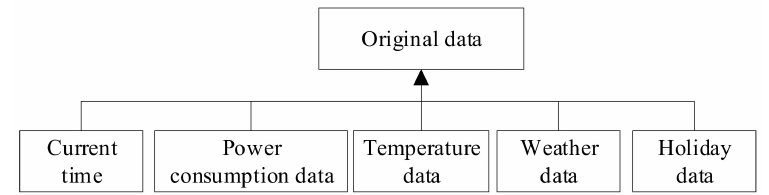
Figure 4. Flowchart of the LMD decomposition